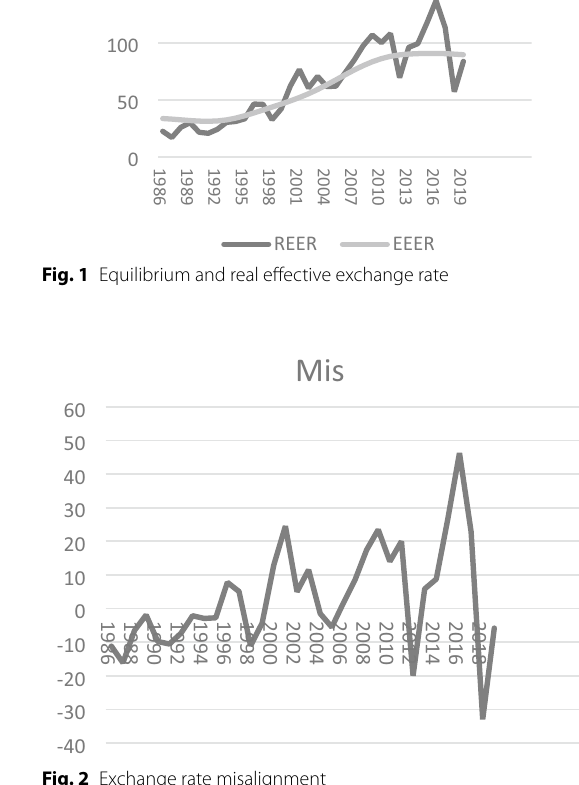
Fig. 2 Exchange rate